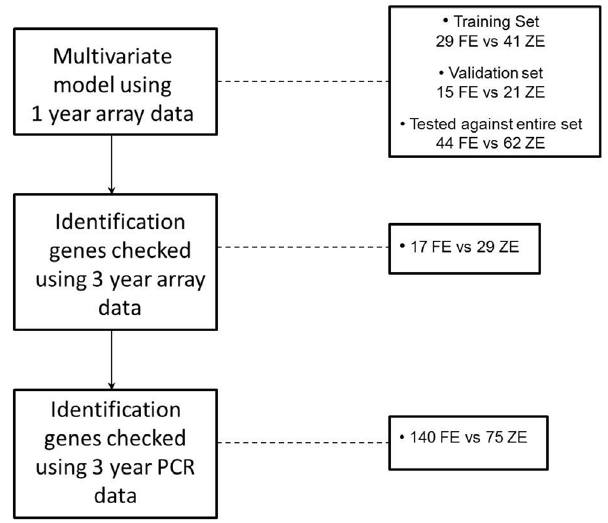
Figure 1. Identification of a set of genes in blood associated with the frequent exacerbator phenotype; multivariate analy- sis using micro-array data 1 year follow up data (n=106), followed by univariate analysis of 3 year follow up data (n=46) and univariate analysis of a different population (n=215) by PCR. FE= frequent exacerbators; ZE = zero